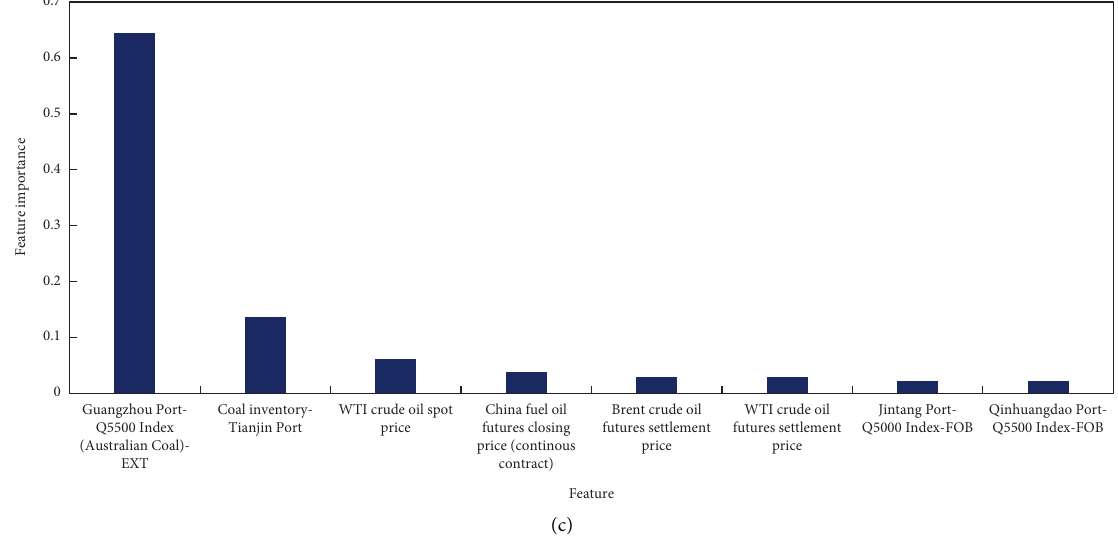
Figure 10: Feature importance for (a) daily, (b) weekly, and (c) monthly CBCFI forecasting